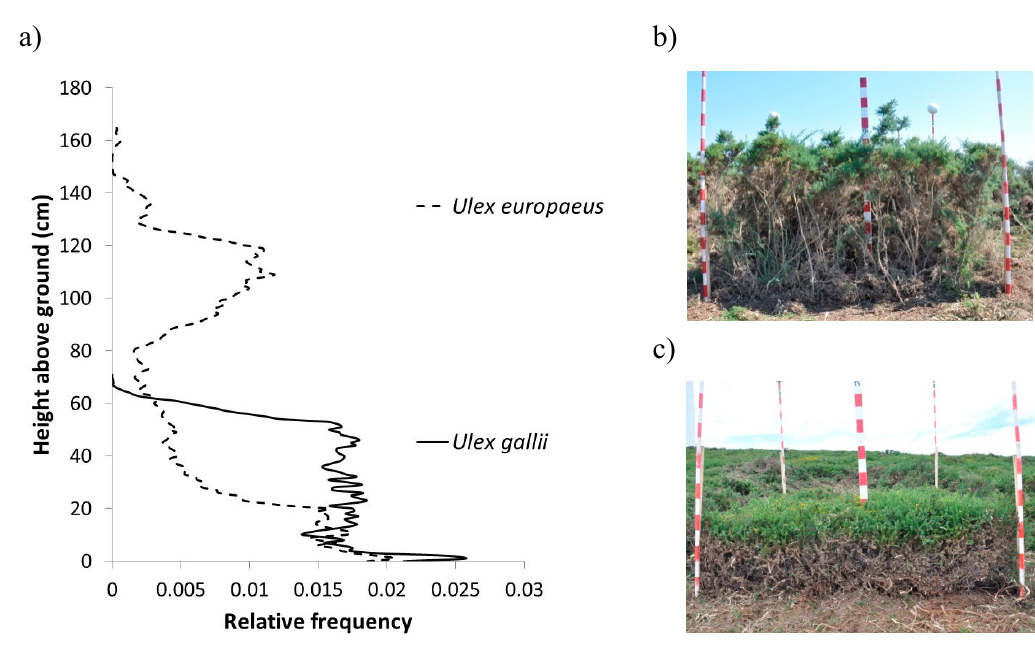
Figure 4. Vertical distribution of the relative frequency of TLS returns ( a ) in two fuel plots with different vertical structure ( b ) Ulex europaeus and ( c ) Ulex gallii .